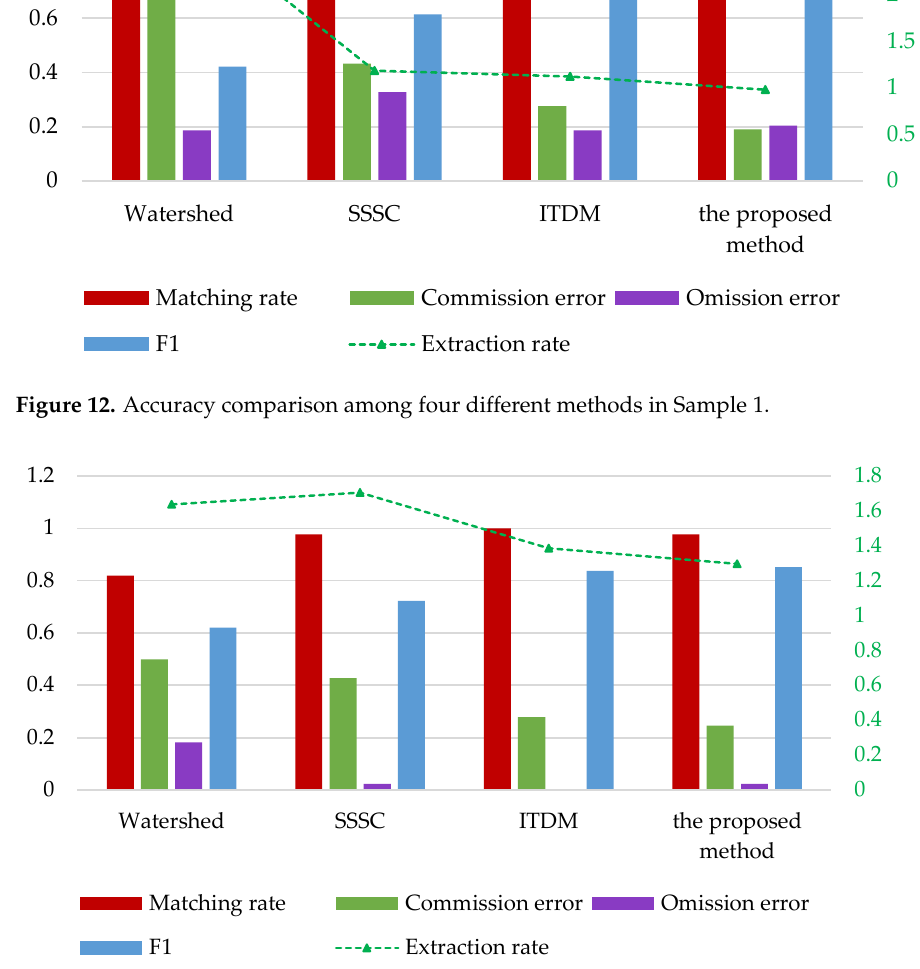
Figure 13. Accuracy comparison among four different methods in Sample 2.